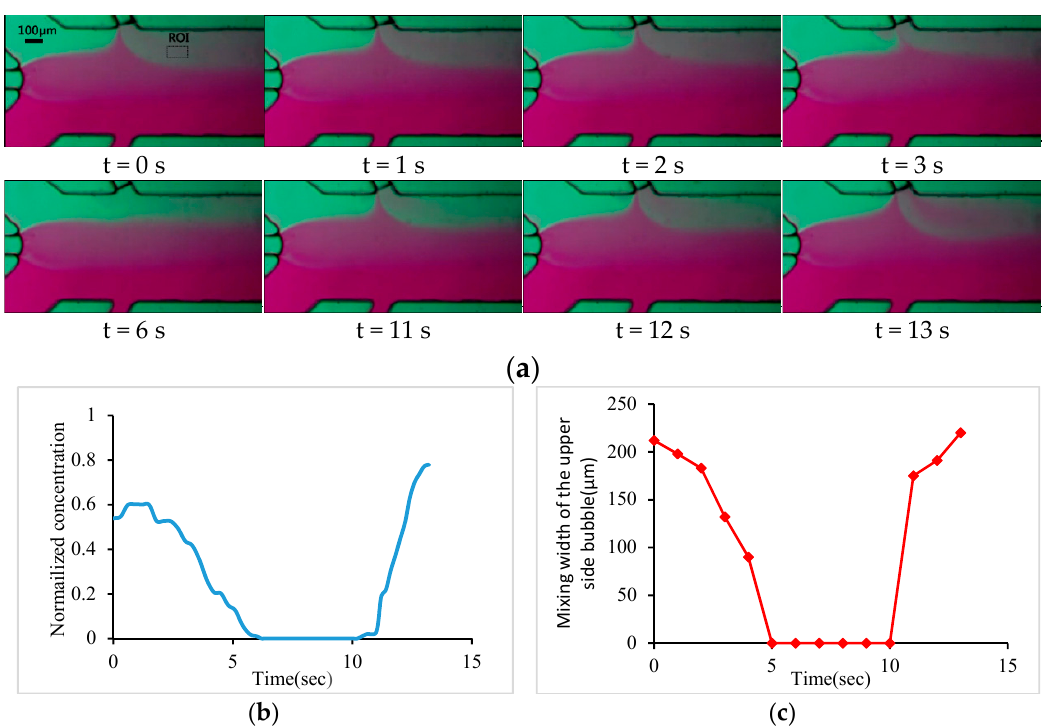
Figure 5. ( a ) Photographs of the concentration gradient in the main channel when the upper oscillating bubble moves away from and close to the main channel; ( b ) concentration of region of interest (ROI) during the movement of upper oscillating bubble; ( c ) mixing width of upper bubble during its movement.